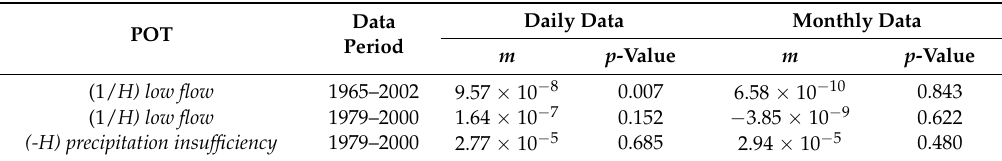
Table 4. Statistical results on the analysis of trend magnitude ( m